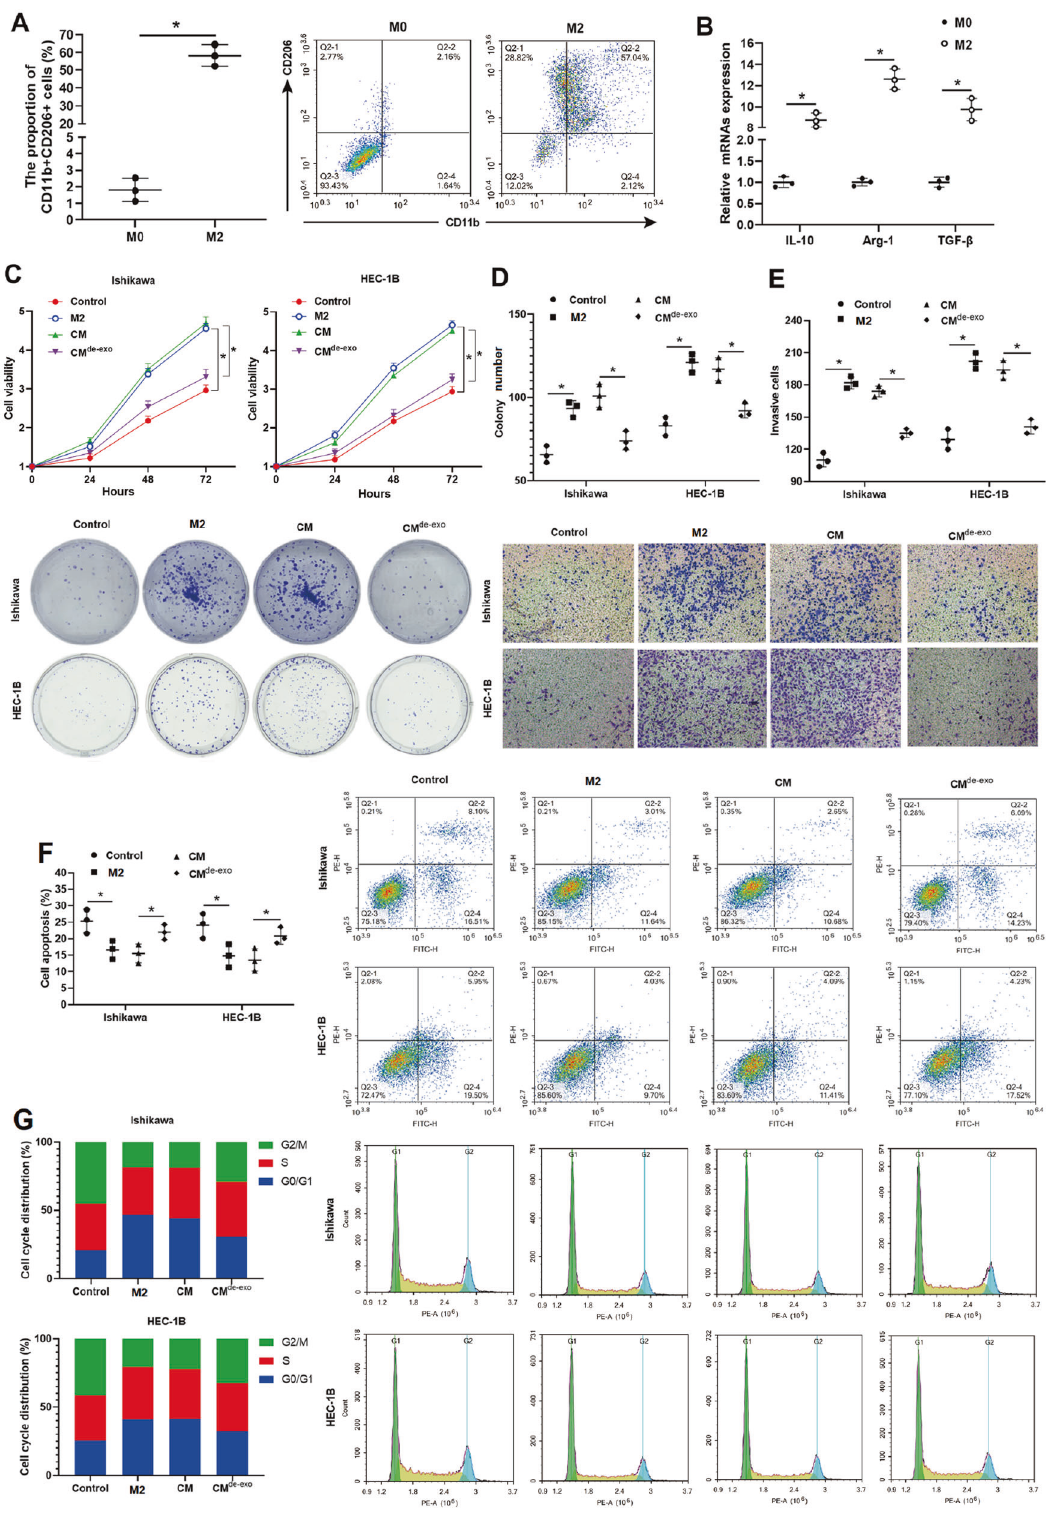
Fig. 2 M2-polarized macrophage-derived exosomes weakened the radiosensitivity of EC cells. A Flow cytometry analysis and quanti fi cation of CD11b + CD206 + cells and B qRT-PCR analysis of IL-10, Arg-1, and TGF- β mRNA levels were performed on nonpolarized M0/ M2-polarized macrophages generated from THP-1 cells. C – G The conditioned medium (CM) and conditioned medium deleted exosomes (CM de-EXO ) were harvested from the M2-polarized macrophages culture medium. EC cell lines (Ishikawa and HEC-1B) were monocultured or cocultured with M2-polarized macrophages/CM/CM de-EXO and then treated with 4 Gy irradiation. C Cell viability was measured by 3-(4,5- dimethylthiazol-2-yl)-2,5-diphenyltetrazolium bromide (MTT) assay. D Cell proliferation was measured by colony formation assay. E Cell invasion was measured by Transwell assay. F Cell apoptosis was measured by fl ow cytometry. G Cell cycle distribution was determined by propidium iodide (PI) staining. * p < 0.05. Cell Death and Disease (2021)